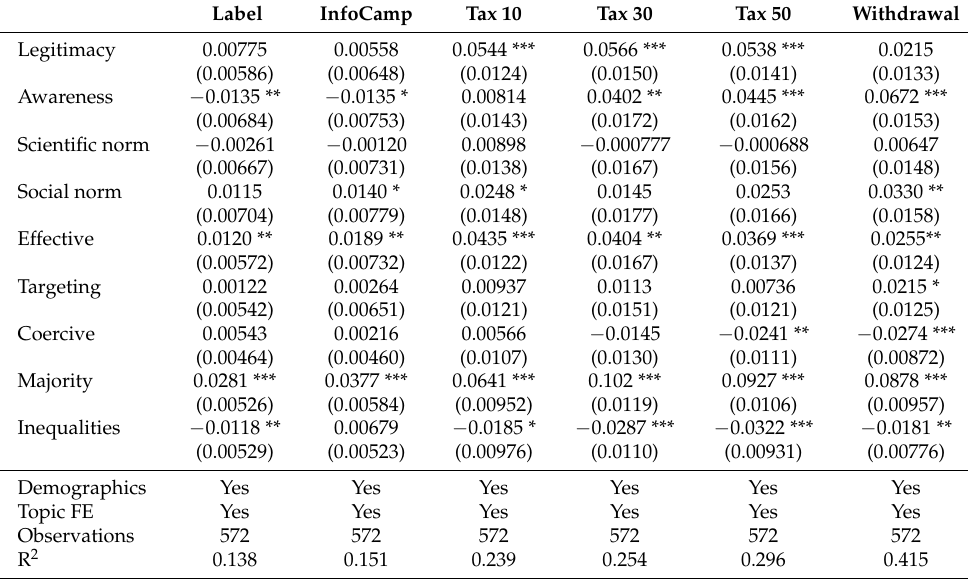
Table A5. Regression of hypothetical votes by policy.